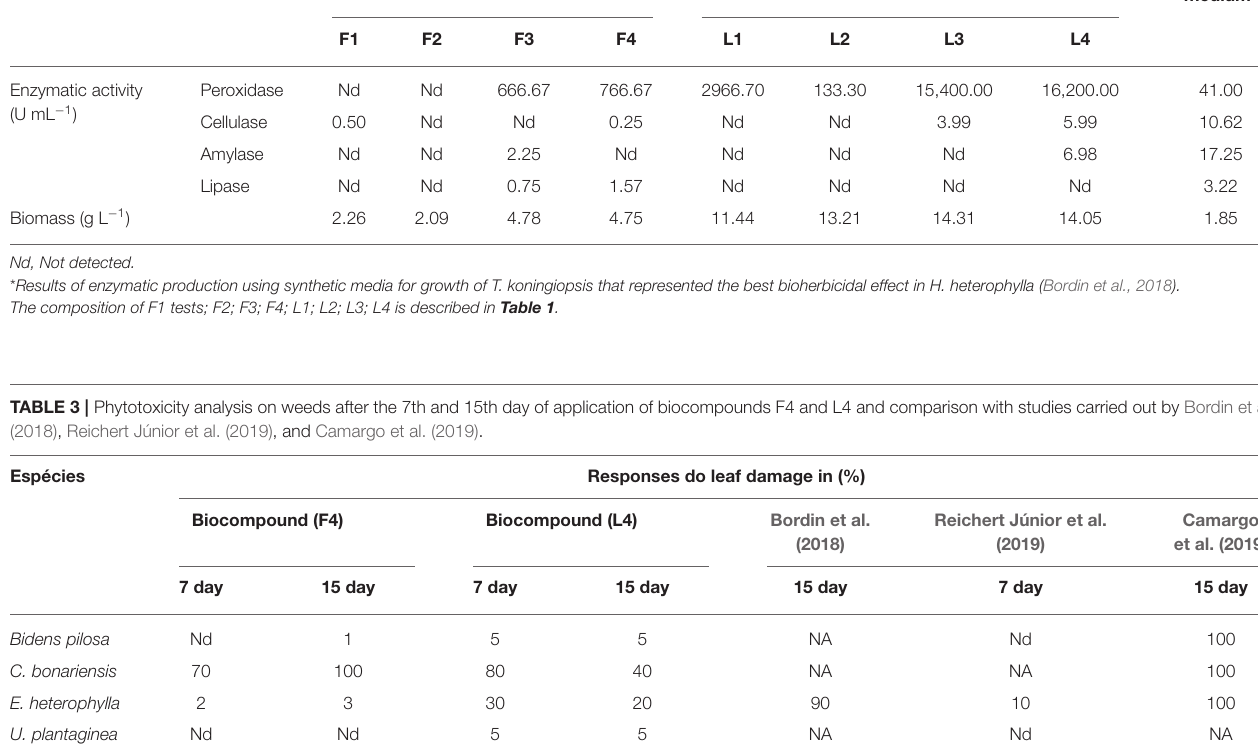
TABLE 2 | Enzymatic activity and biomass production of fermentative extracts using T. koningiopsis and microalgae raw and lyophilized under different conditions. Conditions